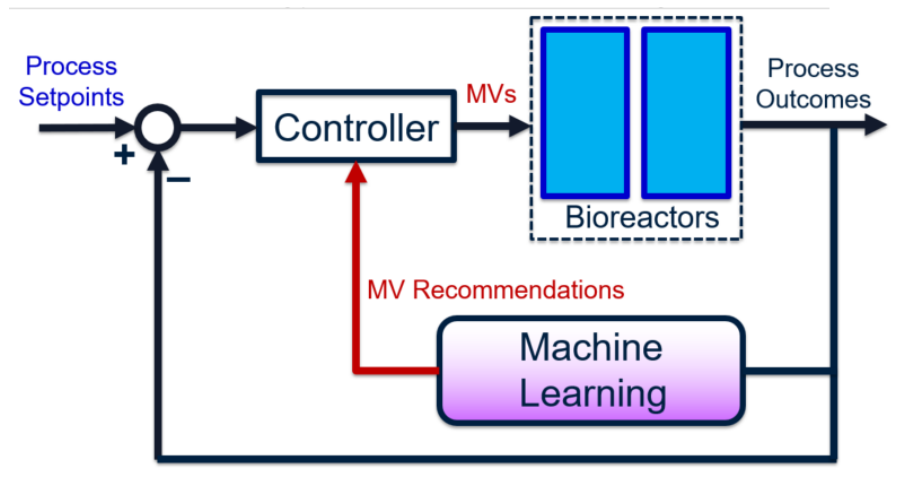
Figure 1. Machine learning (ML)-guided process control and decision-making. Manipulated variables (MVs) selected from the original process features may be high-dimensional and full of confounding effects. Instead, the small subset of MVs most responsible for causing observed process changes is identified using ML algorithms. The key MVs may change from one operating stage to another, but they can be re-identified given the corresponding new